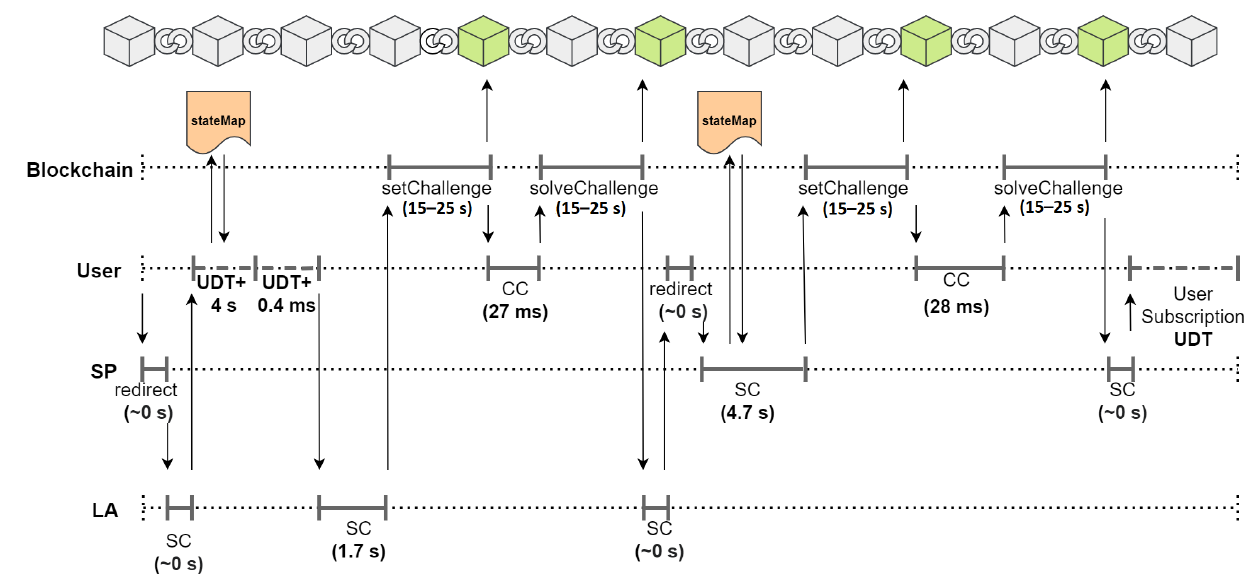
Figure 13. Timeline of the interactions between user, LA , SP , and